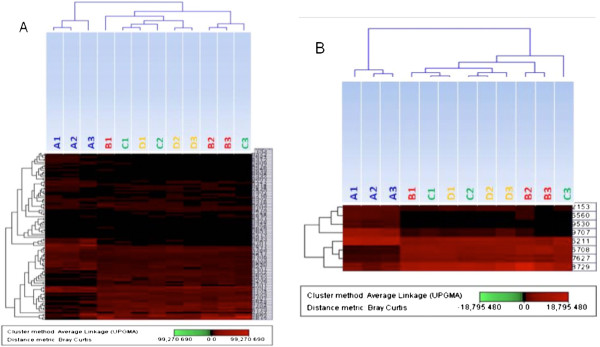
Hierarchical Cluster analysis of fenugreek samples from region A away from the other three different regional fenugreek types using expression dataset from (A) 105 and (B) 8 protein spots that differed significantly using PLS and students-t test analyses respectively.